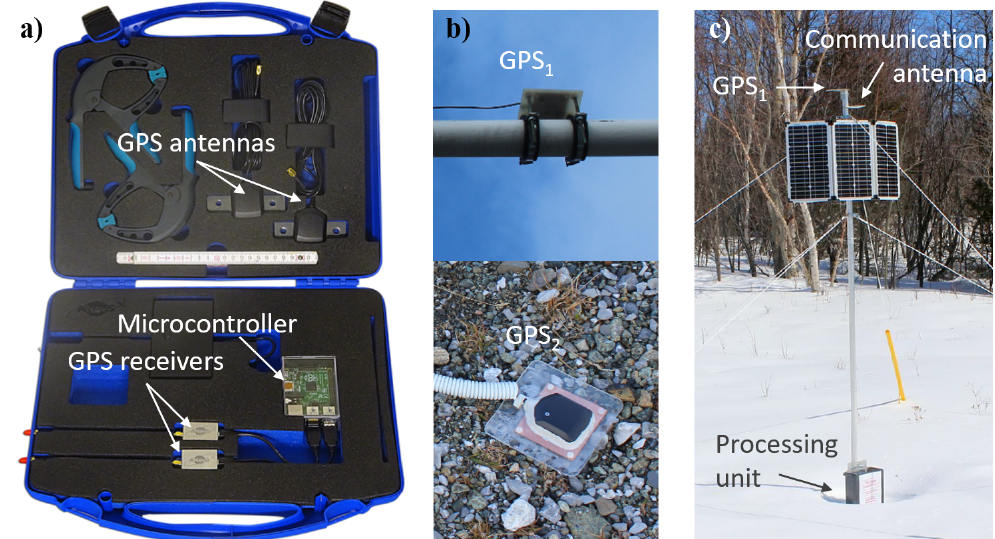
Figure 3. ( a ) demo suitcase with the applied low-cost LEA-M8T GPS receivers (u-blox, Thalwil, Switzerland), u-blox patch antennas and a small microcontroller and data storage; ( b ) examples of GPS antennas of GPS 1 mounted at a pole and of GPS 2 laid out on the ground before snowfall; ( c ) example